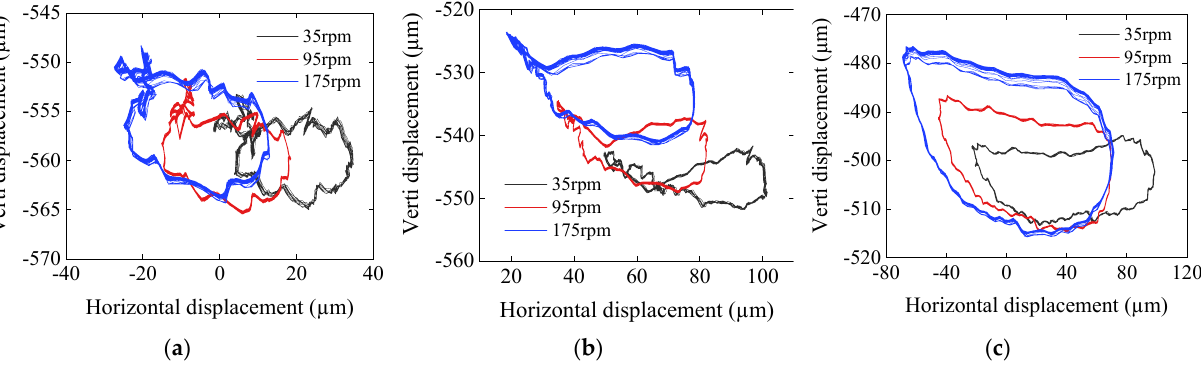
Figure 11. Comparison of axial orbits at different speeds: ( a ) D 1 section; ( b ) D 2 section; and ( c ) D 3 section. The journal position status of the test sections at different rotational speeds are shown in Figure 12. With increased rotational speed, each section moves to the upper left, eccen- tricity decreases, and eccentricity angle increases. The eccentricities of the three sections decrease by 1.45%, 3.56%, and 0.66%, respectively, with the speed increasing from 35 rpm to 175 rpm. The axis heights increase by 0.525%, 3.741%, and 2.540%, respectively, indi- cating that the increase in speed intensifies the deflection of the journal. Comparing the axial-position change pattern of three sections, it can be seen that the change amplitude of the axial orbit in the horizontal direction is larger than that in the vertical direction. The relative differences between the three sections’ horizontal and vertical displacement are 81.33%, 49.69%, and 86.44%, respectively, with the speed increasing from 35 rpm to 175 rpm. From the above analysis, it is clear that the journal in the stern bearing bore presents a complex bending state. The stern bearing has multiple lubrication states, each lubrication region along with the axial distribution.